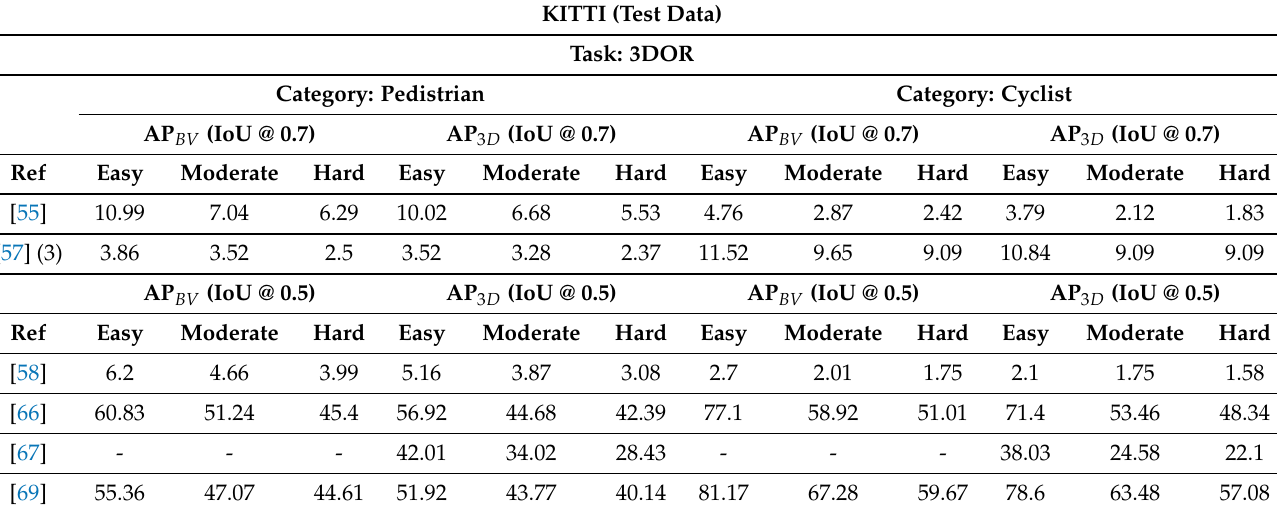
Table 24. Comparison of the Results on the KITTI Validation Dataset for the Pedestrian and Cyclist Categories. KITTI (Test